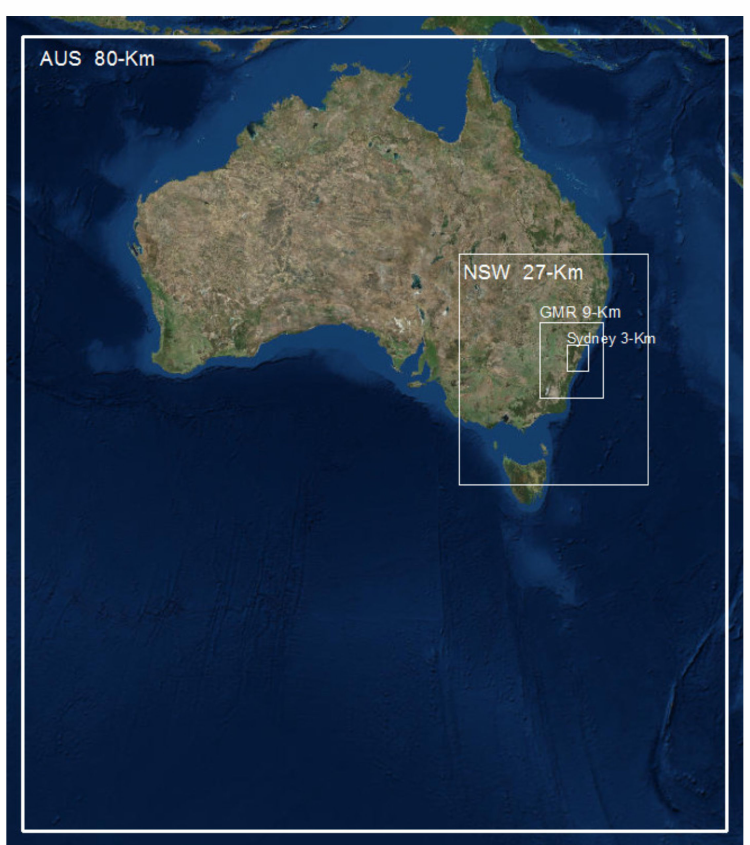
Figure 2. CCAM-CTM nested modelling